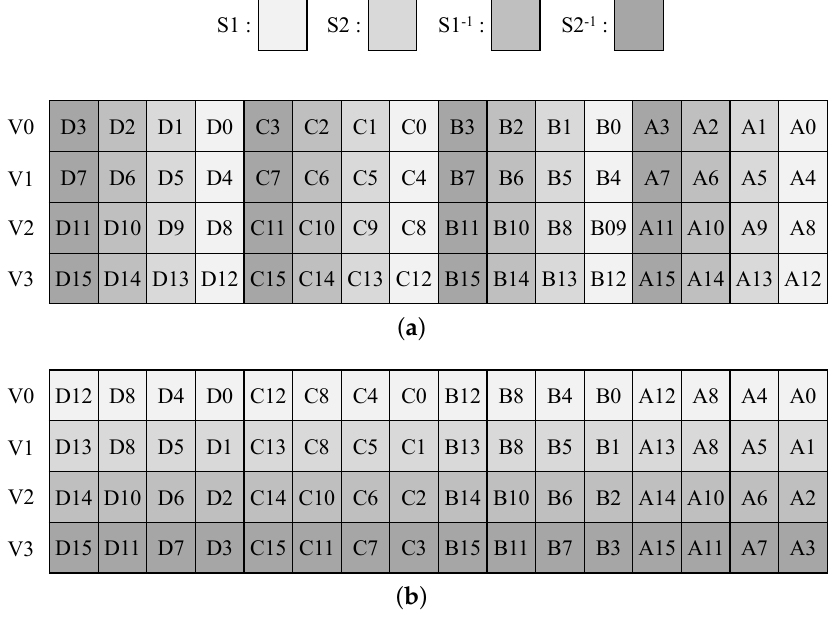
Figure 4. Two types of state for 4-PT parallel implementation. ( a ) 4-PT state Type 1. ( b ) 4-PT state Type